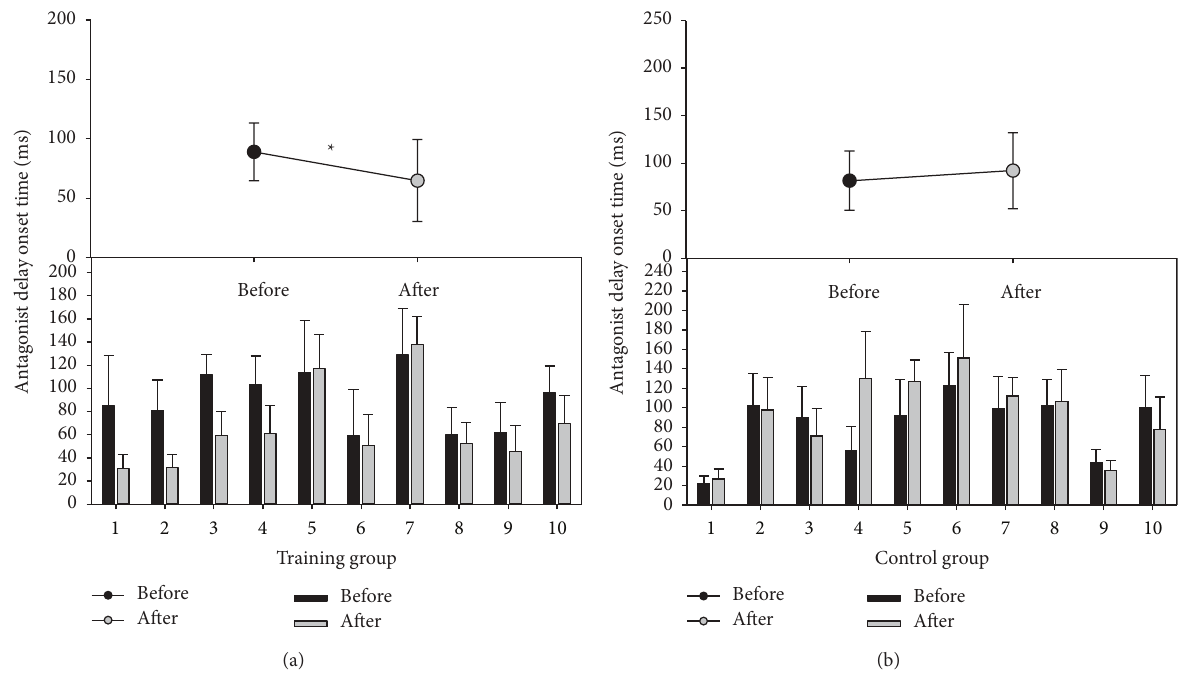
Figure 3: The latency of antagonist muscle activation (AG1-ANT latency) during fast goal-directed wrist extension movement in the training group (a) and the control group (b). The upper panel shows the group means and standard deviations. The lower panel shows the individual means and standard deviations. The black circle and bars indicate before training, and the gray circle and bars indicate after 4 weeks of training. 𝑃 > 0.05 before and after 4 weeks.